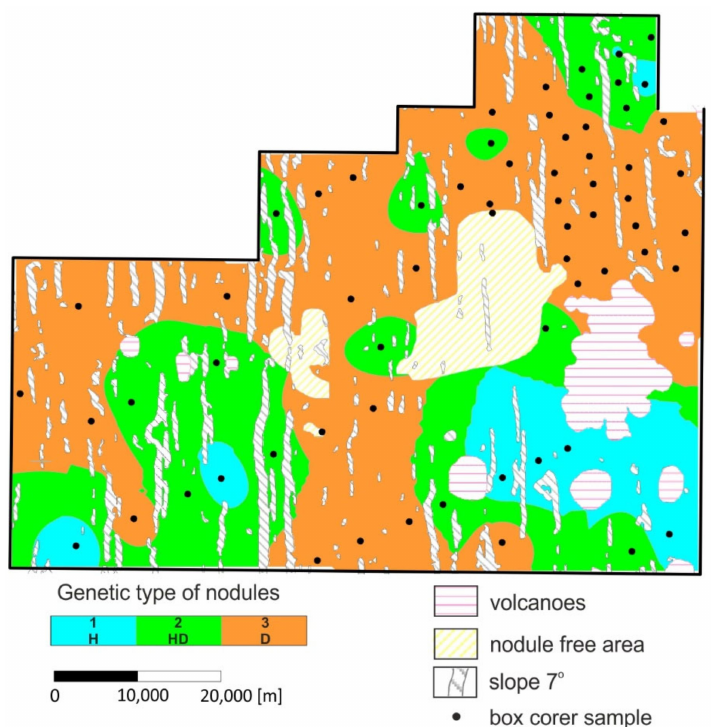
Figure 11. Map of dominant genetic types of nodules in the H22 exploration